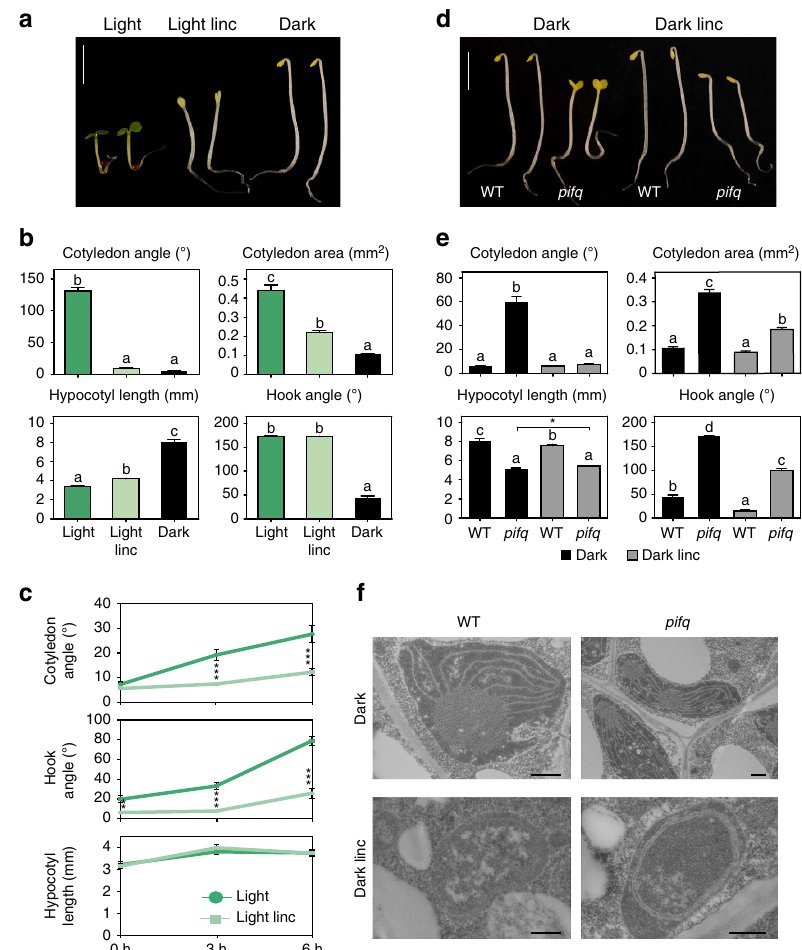
Figure 1 | RS from the chloroplast suppresses PIF-mediated seedling photomorphogenesis. ( a ) Lincomycin treatment prevents Arabidopsis seedling deetiolation in continuous white light. WT seedlings were grown for 3 days in the light in the absence (Light) or presence (Light linc) of lincomycin. For comparison, 3-day-old dark-grown seedlings are shown at right. Scale bar, 2.5mm. ( b ) Cotyledon angle and area, hypocotyl length and hook angle of seedlings grown as in a. ( c ) Lincomycin inhibits early deetiolation during the transition of dark-grown seedlings to light. Quantification of cotyledon angle (top), hook angle (middle) and hypocotyl length (bottom) of 2-day-old dark-grown WTseedlings transferred to white light for the indicated times, grown in the absence (dark green) or presence (light green) of lincomycin. ( d ) Lincomycin treatment suppresses the cop -like phenotype of pifq seedlings in the dark. WT and pifq seedlings were grown for 3 days in the dark in the absence (Dark) or presence (Dark linc) of lincomycin. ( e ) Cotyledon angle and area, hypocotyl length and hook angle of seedlings grown as in d. ( f ) Higher-magnification micrographs of samples prepared as in d. Representative etioplasts are shown for WT (left) and pifq (right) seedlings grown in absence (top) or presence (bottom) of lincomycin. Scale bar, 500nm. Error bars in b , c and e represent s.e.m. ( n Z 20). The experiments were repeated two times with similar results. In b , e different letters denote statistically significant differences among means by Tukey-b test ( P o 0.05). In c and e , statistically significant differences between mean values by Student’s t -test are shown (* P o 0.05; ** P o 0.01 and *** P o